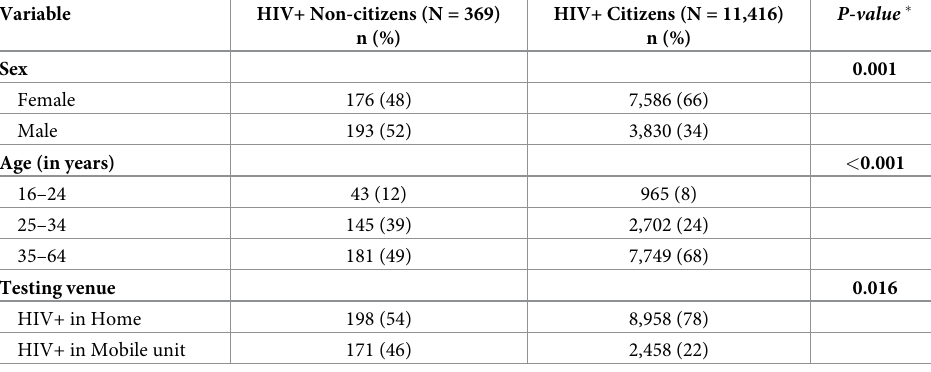
Table 2. Characteristics of HIV-Positive Non-Citizens and Citizens.